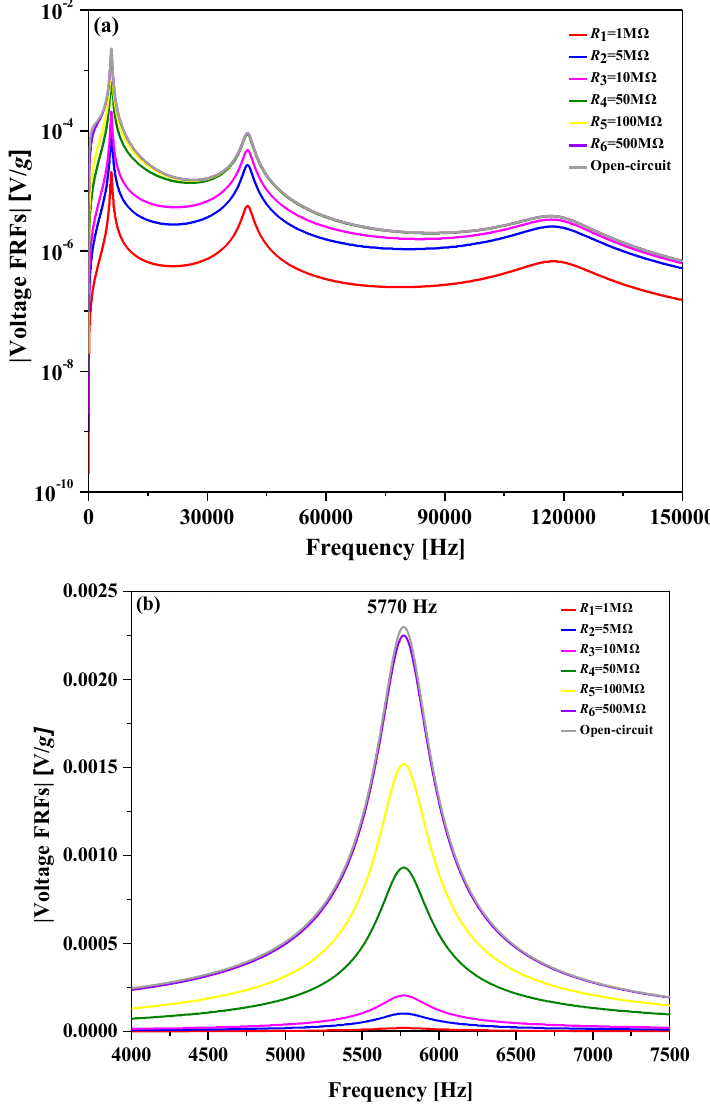
Figure 2. Voltage frequency response functions (FRFs) of the flexoelectric beam with 3 μm thickness over the frequency range of ( a ) the first three modes; ( b ) around the first mode.